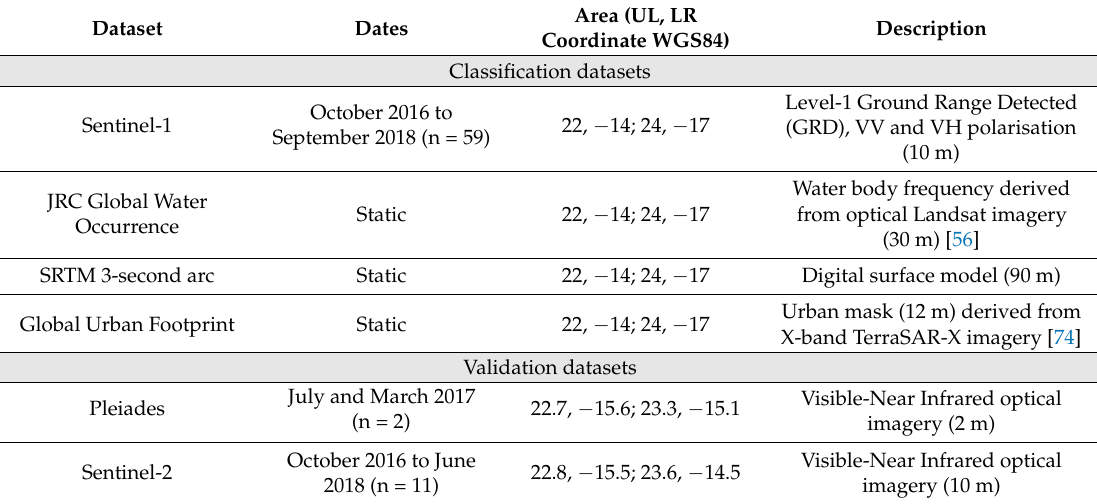
Table 1. Summary of the datasets used for developing the water body classification and for validating the resulting water body